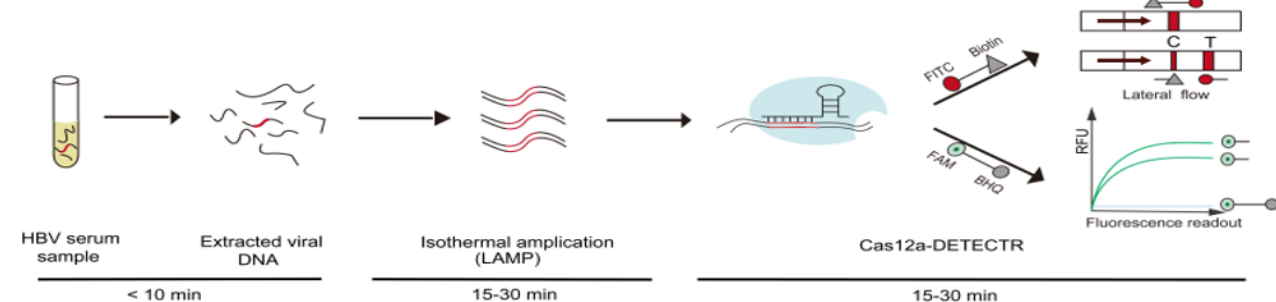
Figure 1. Cas12a-DETECTR assay of HBV DNA. After HBV serum samples were rapidly processed within 10 min, the extracted HBV DNA was amplified by performing LAMP of the target sequence (15–30 min). Cognate binding of the Cas12a–crRNA complex to amplified HBV DNA targets triggered the collateral activity of Cas12a, which cleaved ssDNA reporters (15–30 min). The cleaved ssDNA is visualized by both fluorescence readout (FAM-BHQ) and lateral flow test strips